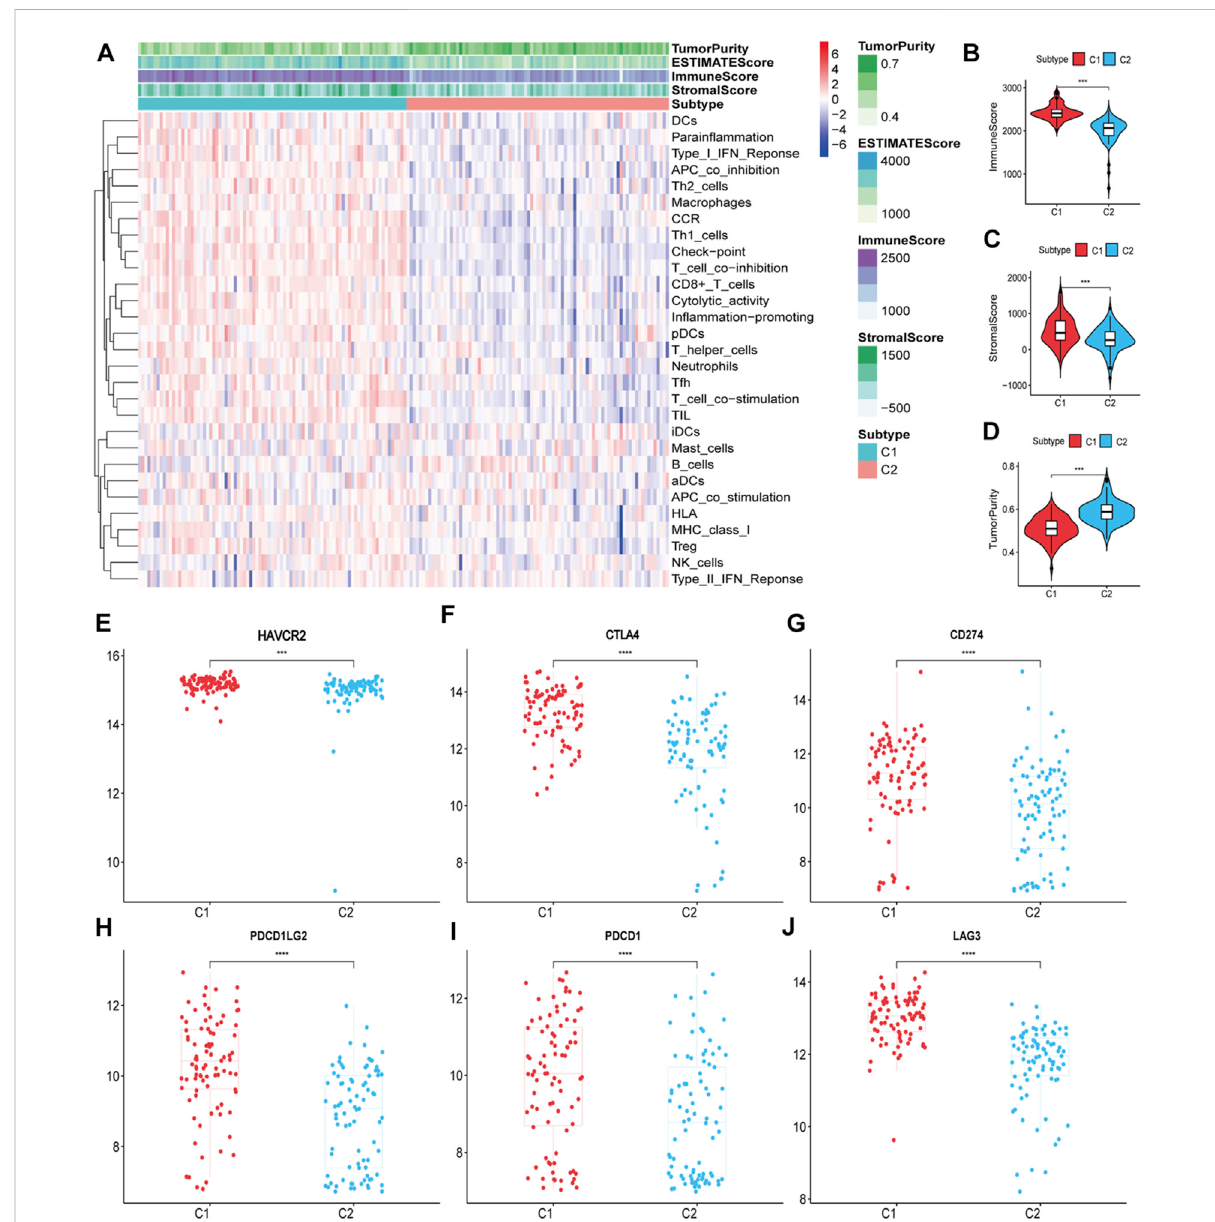
FIGURE 3 Identi fi cation of the two subtypes in the validation set. (A) Heatmap of the two subtypes based on ssGSEA scores for 29 immune gene sets. (B – D) Evaluation of stromal scores, immune scores, ESTIMATE scores and tumor purity for the two subtypes. (E – J) The expression differences of immune checkpoint genes between the two subtypes; Bars indicate medians. Wilcoxon test was used to compare gene expression levels between the two subtypes. *** p < 0.001, **** p <